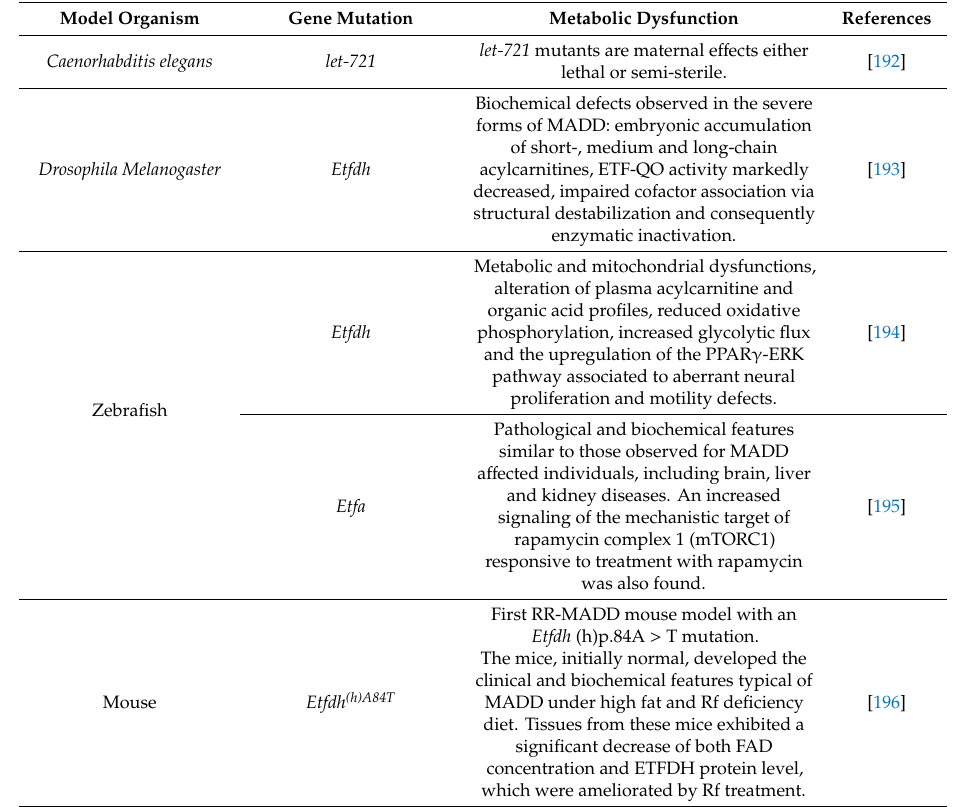
Table 1. Model organisms to study